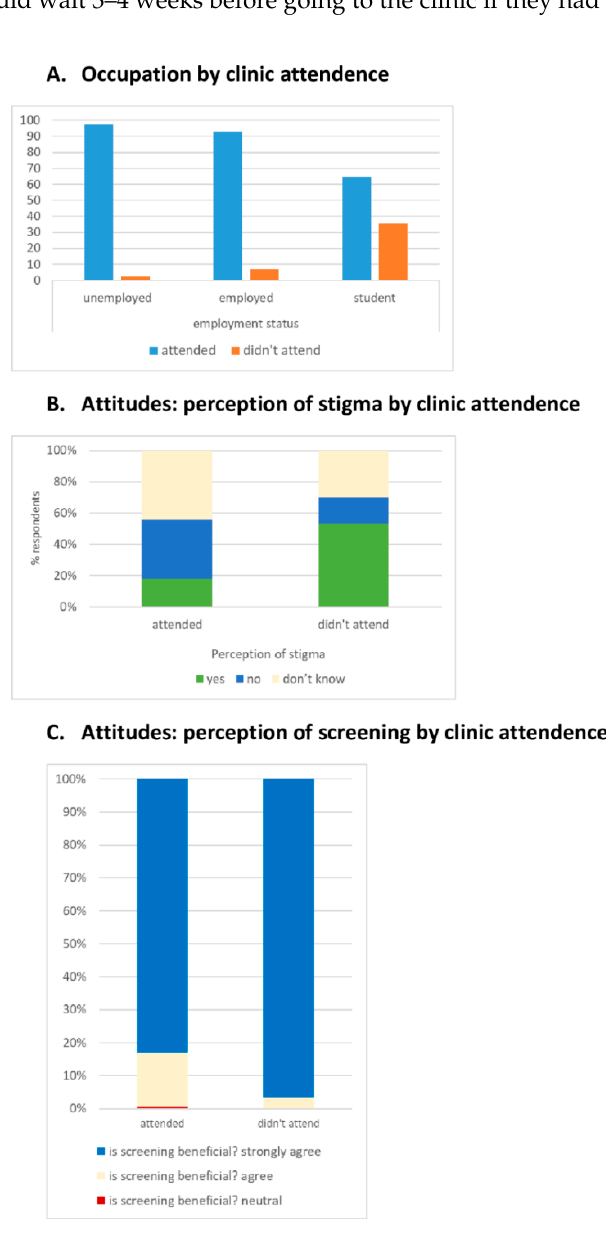
Figure 3. Association between characteristics or beliefs and attendance at clinic for contact screening Study diagram.